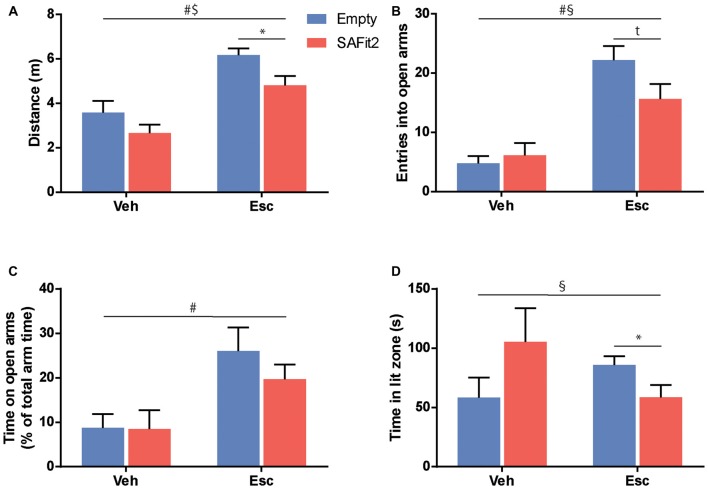
Treatment with SAFit2 and escitalopram (Esc) affected behavior in two different anxiety tests. (A) Overall locomotion in the Elevated Plus Maze (EPM) was increased by Esc treatment and this effect was ameliorated by SAFit2. Anxiety-like behavior in the EPM measured by open arm entries (B) and open arm time (C) was decreased after Esc treatment. When combined with the FK506 binding protein 51 (FKBP51) inhibitor, this effect was reduced for open arm entries, but not significantly for open arm time. (D) In the Dark-Light box (DaLi), we again observed a significant interaction effect when comparing all four groups. #Main Esc effect, $main SAFit2 effect, §Esc–SAFit2 interaction effect, *significant post hoc effect at p < 0.05, tpost hoc trend at p < 0.1.